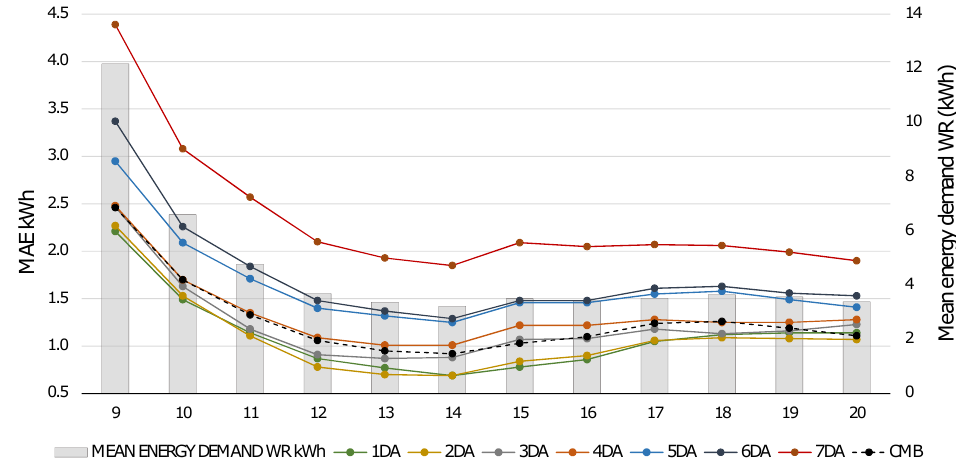
Figure 10. Error metric ( MAE ) for the energy demand